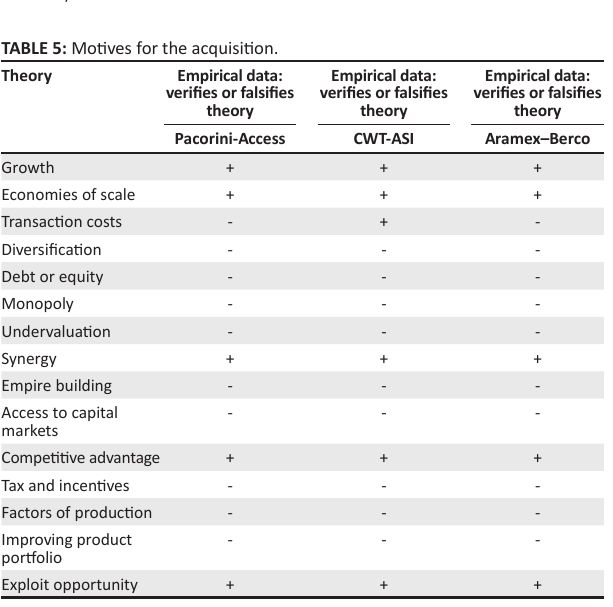
TABLE 5: Motives for the acquisition.